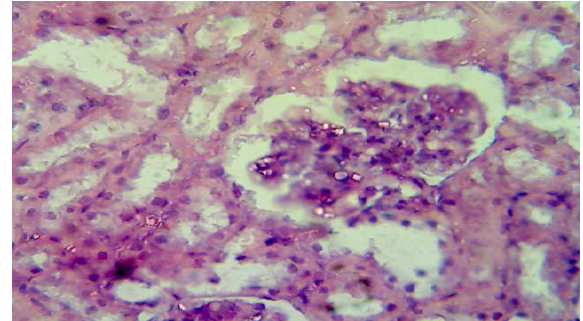
Figure, 15. In section of histopathology in the kidney of rat receiving 1mg/kg B.W. of acrylamide and 250mg/kg B.W. of betaine for 65 days in (G4 group): showed no clear lesions (H. & E.stain